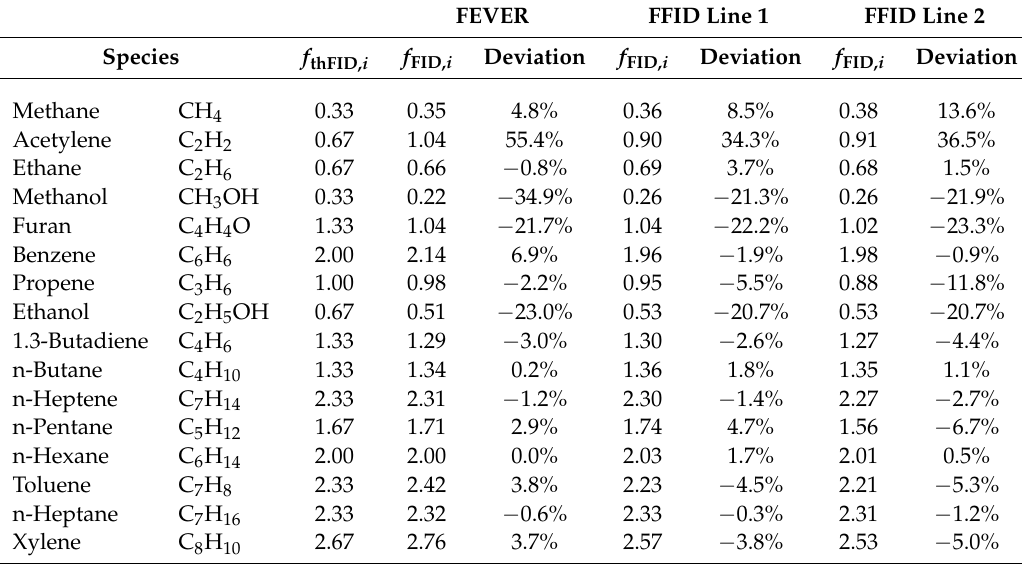
Table A4. FID response factors measured for selected species for the FEVER device and the FFID device (two lines). The theoretical response factor f thFID, i (s.Equation (2)) is compared with the measured one, and the relative deviation is reported